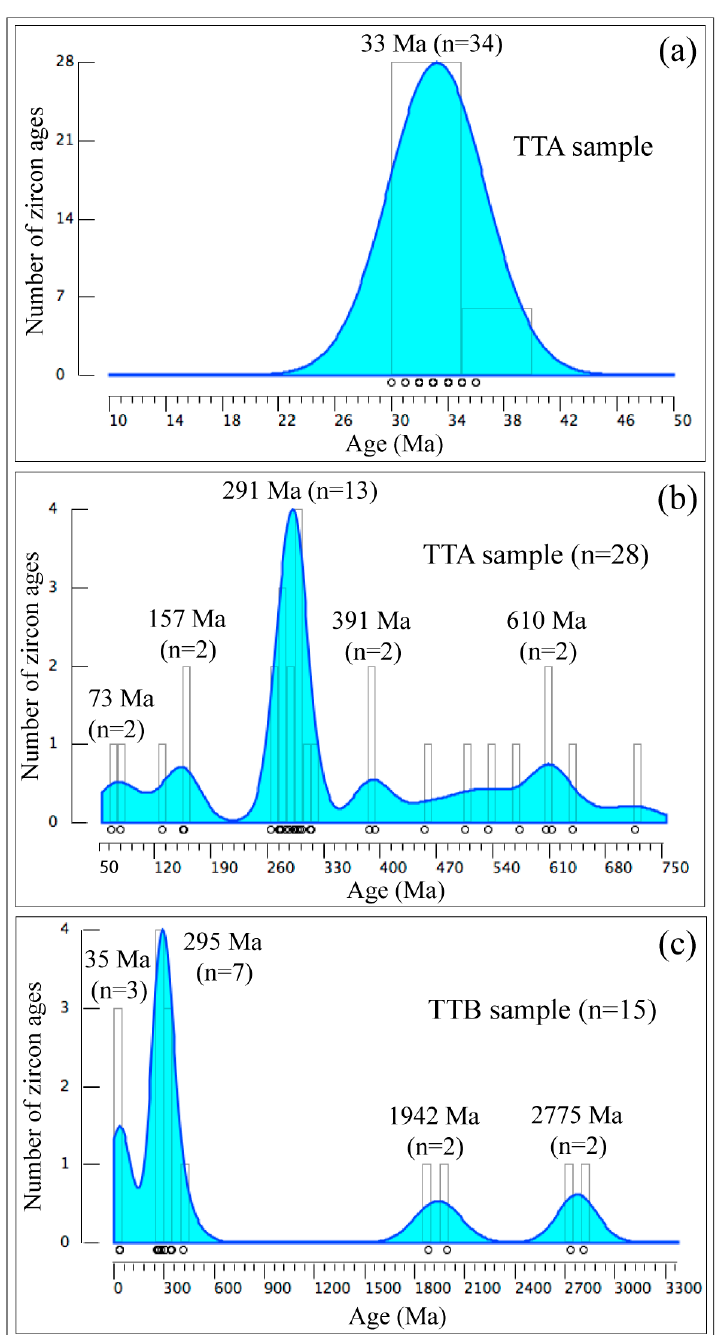
Figure 10. Histogram with Kernel density estimates [54] of the U-Pb zircon ages from the TTA ( a , b ) and TTB ( c ) samples. ( a ) Peak of the Priabonian-Rupelian ages in the TTA sample at 33 Ma; ( b ) pre-Cretaceous ages with peaks at 73 Ma, 157 Ma, and 291 Ma and those of pre-Devonian ages in the TTA sample.